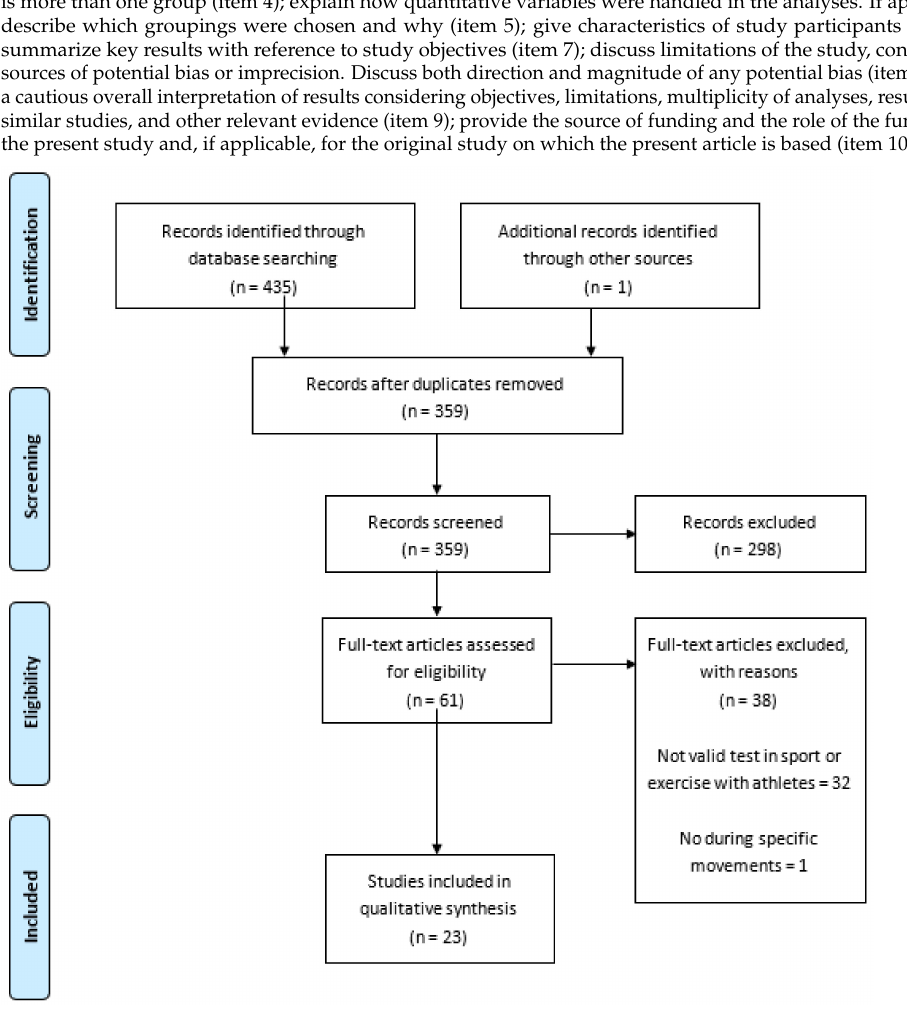
Figure 1. PRISMA flow